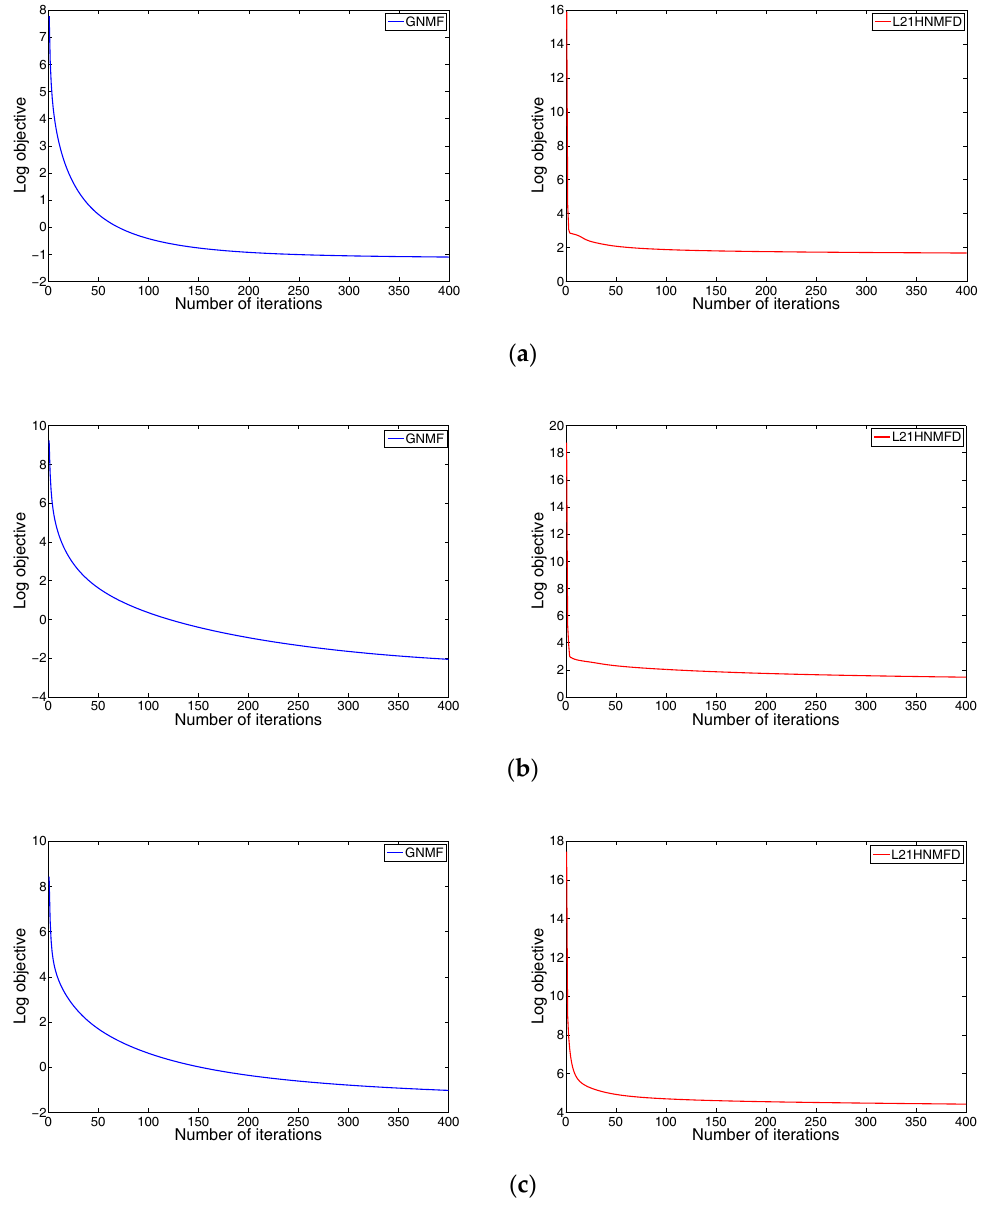
Figure 2. Convergence curve of GNMF and (cid:96) 2,1 HNMFD. ( a ) YALE, ( b ) ORL and ( c )